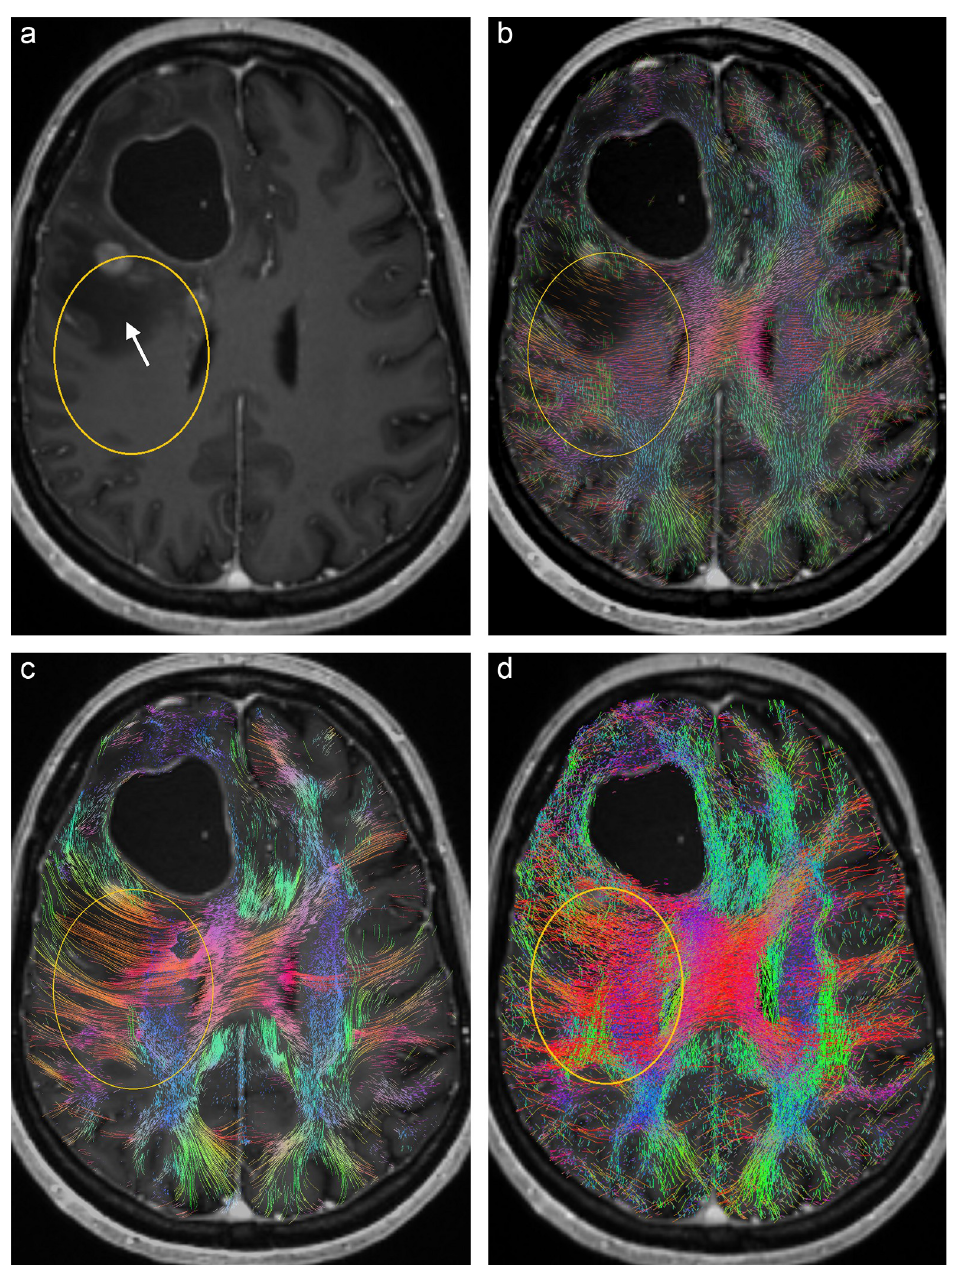
result fused with